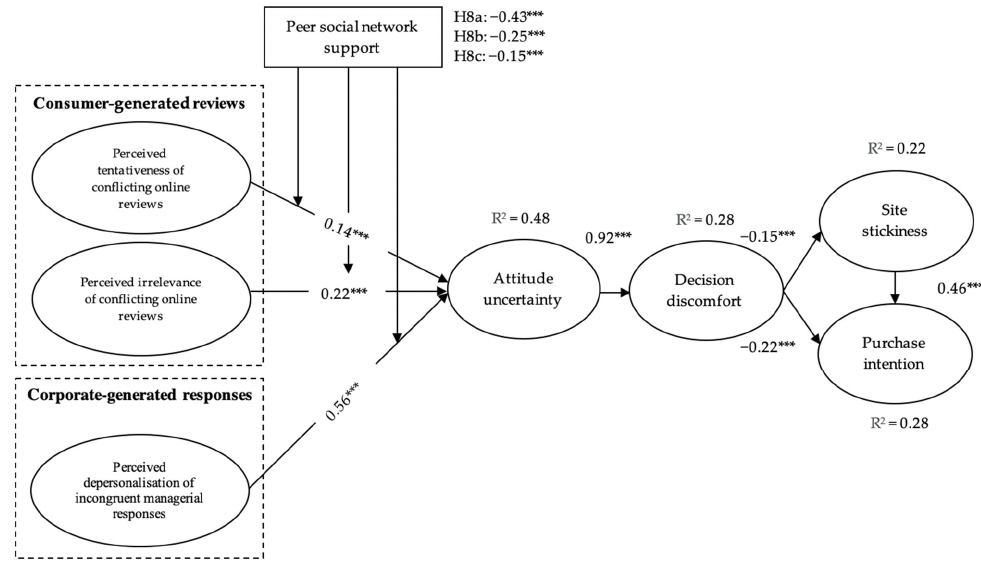
Figure 1. Results of hypotheses. Notes: *** p < 0.001. Table 4. Results of the direct effects.